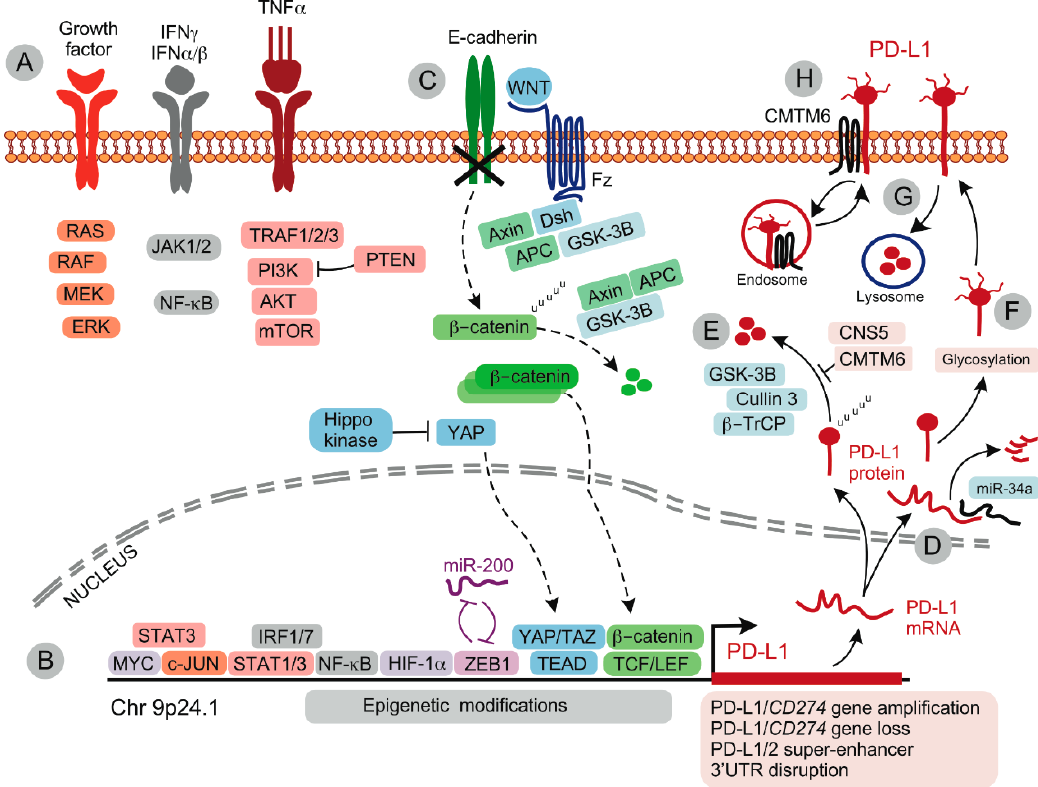
Figure 3. Regulation of PD-L1 expression in tumor cells. ( A ) Signaling via growth factor-, IFN- and TNF α receptors activates multiple signaling pathways that induce PD-L1 / CD274 gene expression. ( B ) Multiple transcription factors can induce PD-L1 expression. PD-L1 gene amplification or loss and epigenetic modifications modulate PD-L1 gene expression. ( C ) In de-differentiated cells undergoing epithelial-to-mesenchymal transition (EMT), loss of E-cadherin drives cytoplasmic translocation of β -catenin that is subject to ubiquitination/destruction by the Axin/APC/GSK-3B complex. Activation of Wnt/Fz/Dsh sequesters the β -catenin destruction complex and allows for the accumulation and nuclear translocation of β -catenin; β -catenin associates with TCF/LEF transcription factors to induce PD-L1 expression. ZEB1 (subject to control by miR-200) and YAP/TAZ-TEAD complexes maintain PD-L1 expression in de-differentiated phenotypes. ( D ) Upon transcription, PD-L1 mRNA is subject to regulation by miRs such as miR-34a. ( E ) PD-L1 protein is unstable, being rapidly ubiquitinated by GSK-3B and cullin 3/ β -TrCP, and degraded. This process is antagonized by CNS5 and CMTM6. ( F ) Glycosylation increases PD-L1 protein stability. ( G ) Cell surface-expressed PD-L1 is internalized and undergoes lysosomal degradation. ( H ) Alternatively, interaction with CMTM6 stabilizes PD-L1 expression by supporting endosomal recycling and preventing proteolytic degradation. Abbreviations: APC, Adenomatous polyposis coli; β -TrCP, Beta-transducin repeats-containing